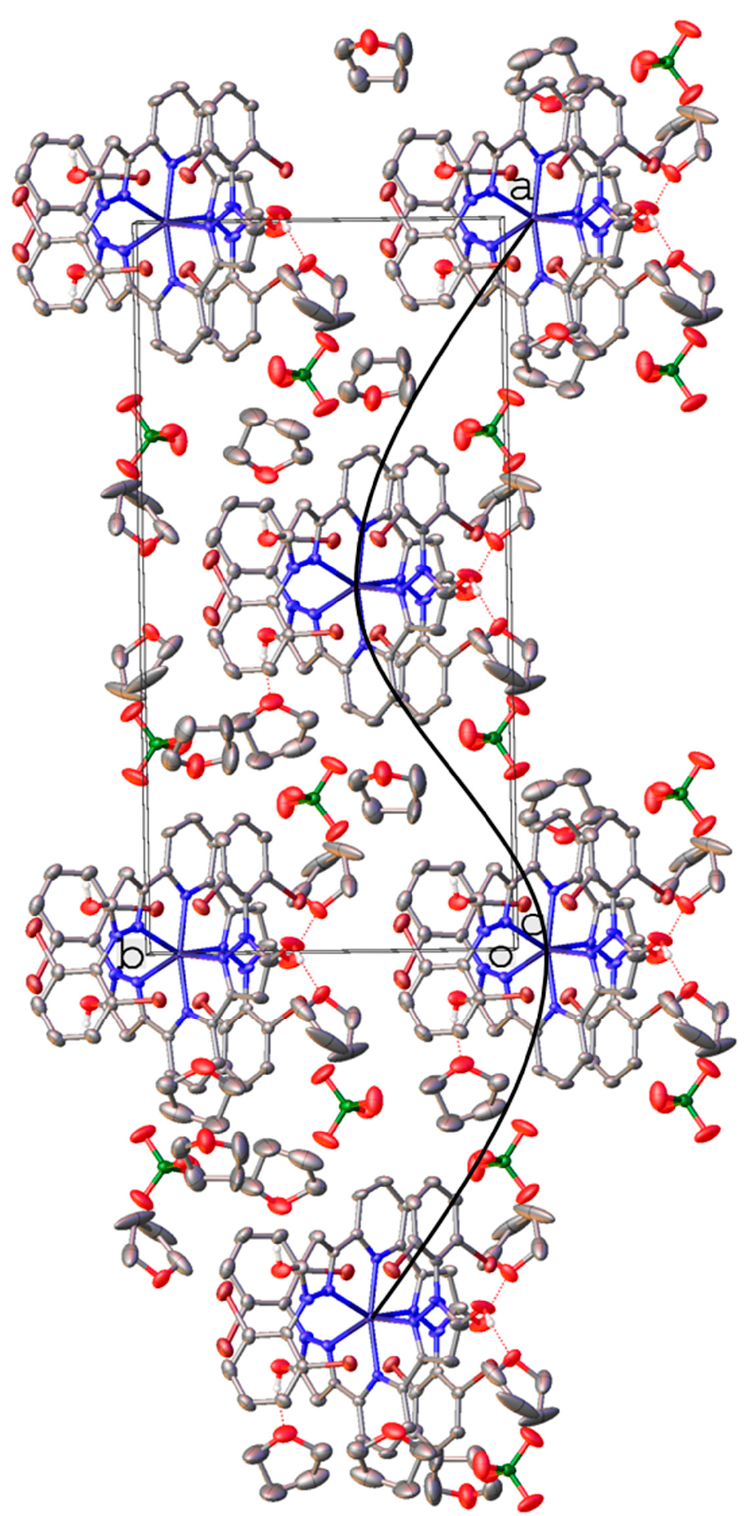
Figure 6. Spiral-like packing of the cations [Fe( L ) 2 ] 2+ in [Fe( L H ) 2 ](ClO 4 ) 2 . For [Fe( L Br ) 2 ](ClO 4 ) 2 and [Fe( L Me ) 2 ](ClO 4 ) 2 , see Figure S8 of ESI.